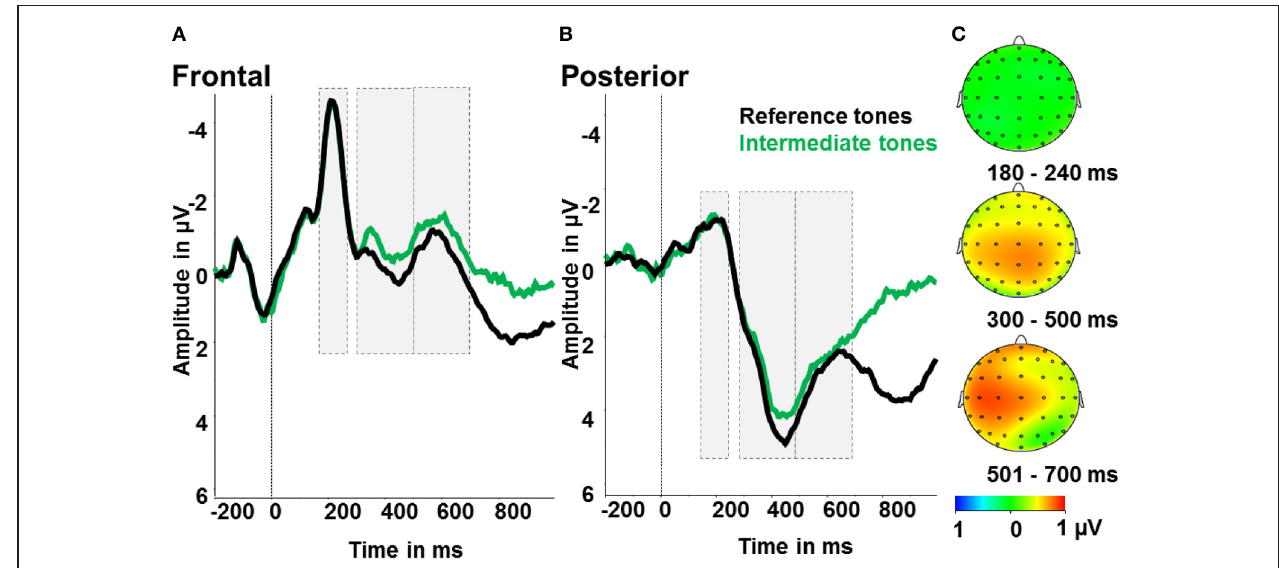
Maps display the activity difference of the reference tones and correct responses minus ambiguous tones and all responses in μ V in the time windows 180–240ms (N2), 300–500ms (early LPP) and 501–700ms (late LPP)